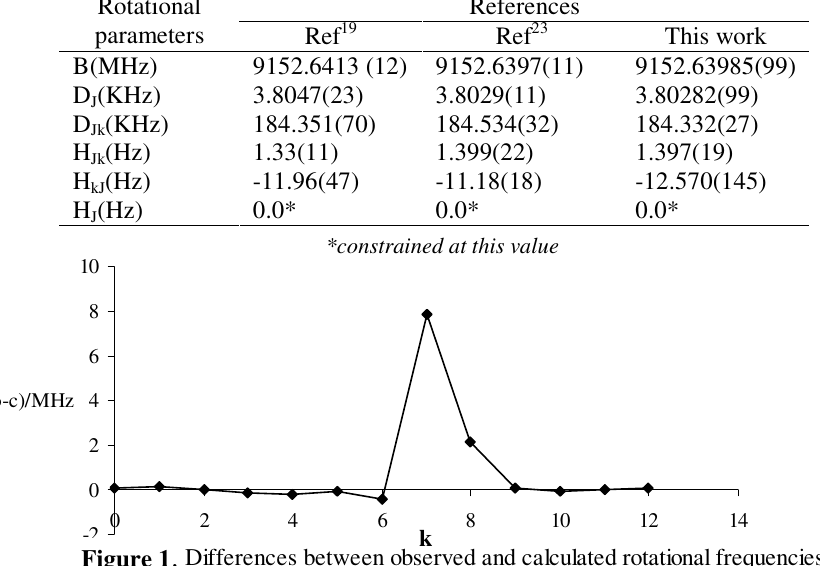
CN in v = 1 state with previous works. 3 4